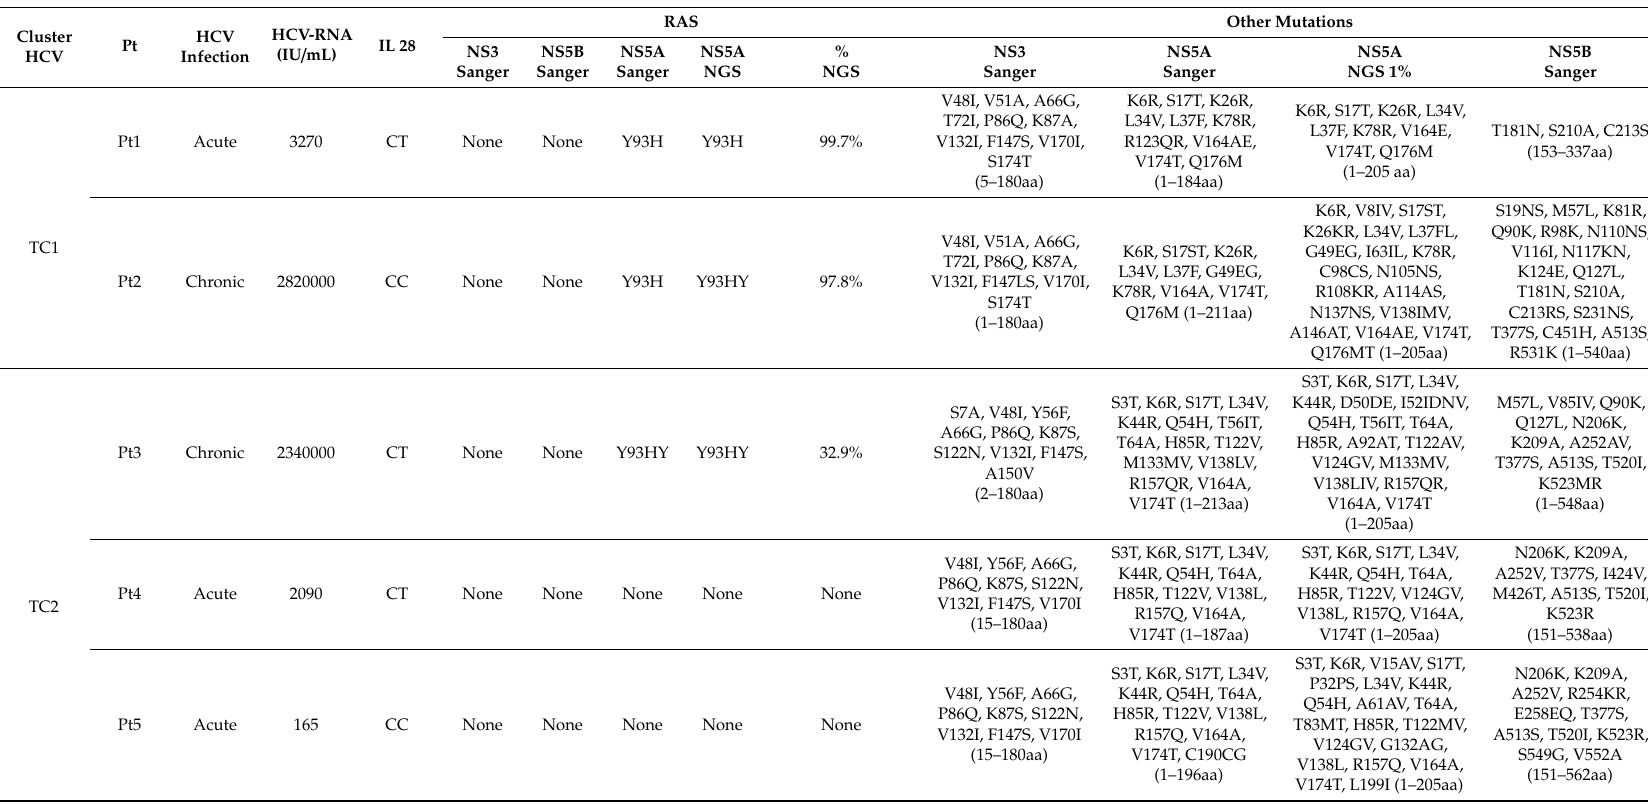
Table 2. List of mutations found in each gene using Geno2pheno for both Sanger and Next-Generation Sequencing (NGS) sequences. Cluster